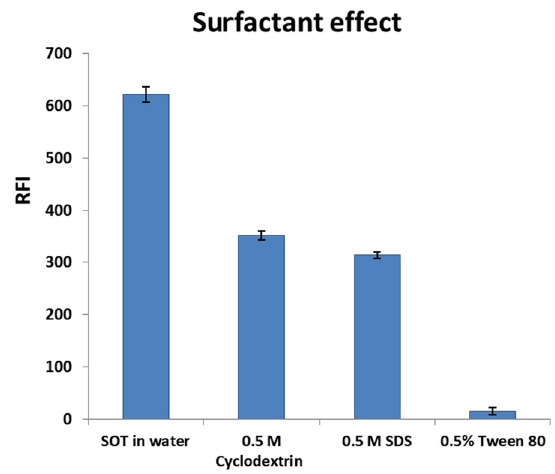
Figure 5: Effect of surfactants on the RFI of SOT (180.0 ng/mL) and n=5.